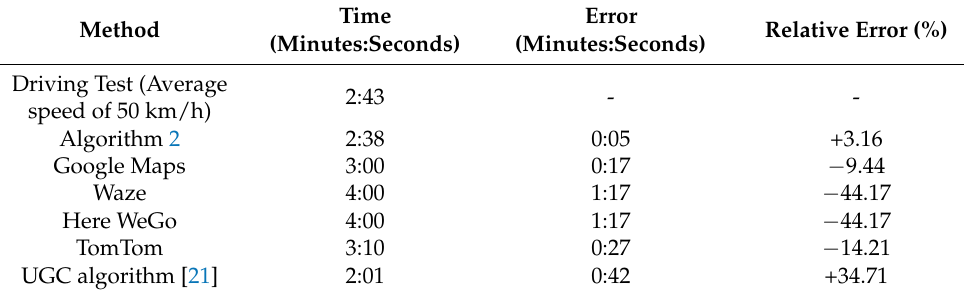
Table 2. Estimation and Error Travel Time along the Minden